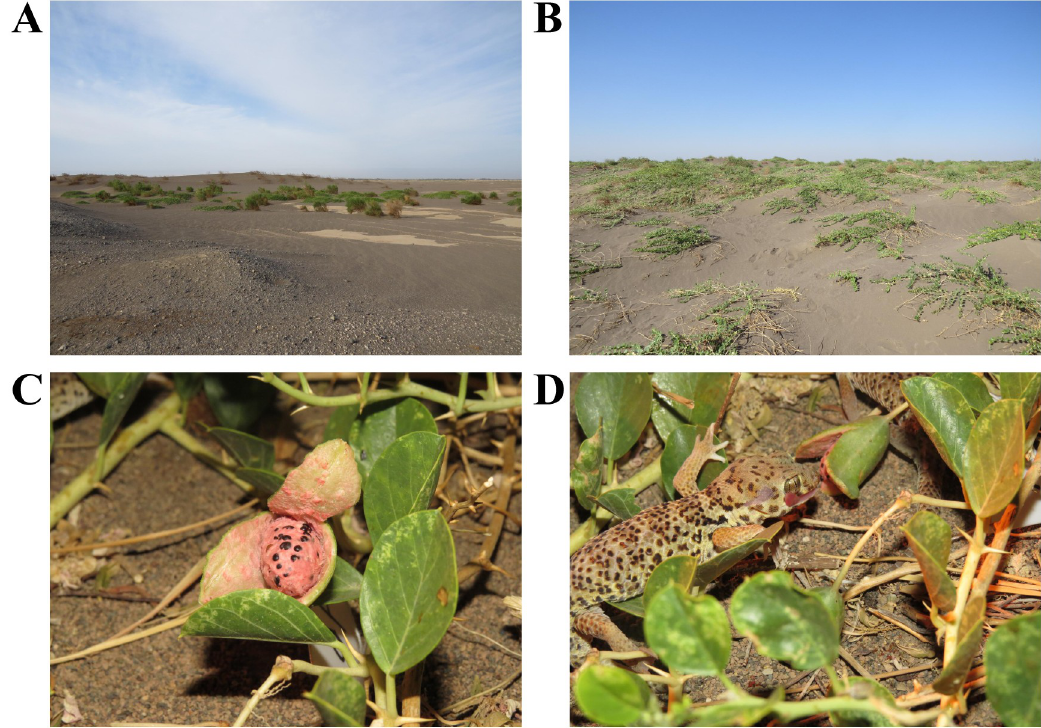
Fig 1. Study area in the Turpan Eremophytes Botanic Garden at the Chinese academy of sciences in the Turpan Basin of northwest China’s Xinjiang Uygur Autonomous Region. (A) Distant view of sample site. (B) Close-up view of sample site. (C) Ripe fruit of C . spinosa . (D) T . roborowskii feeding on the fruit of C . spinosa .